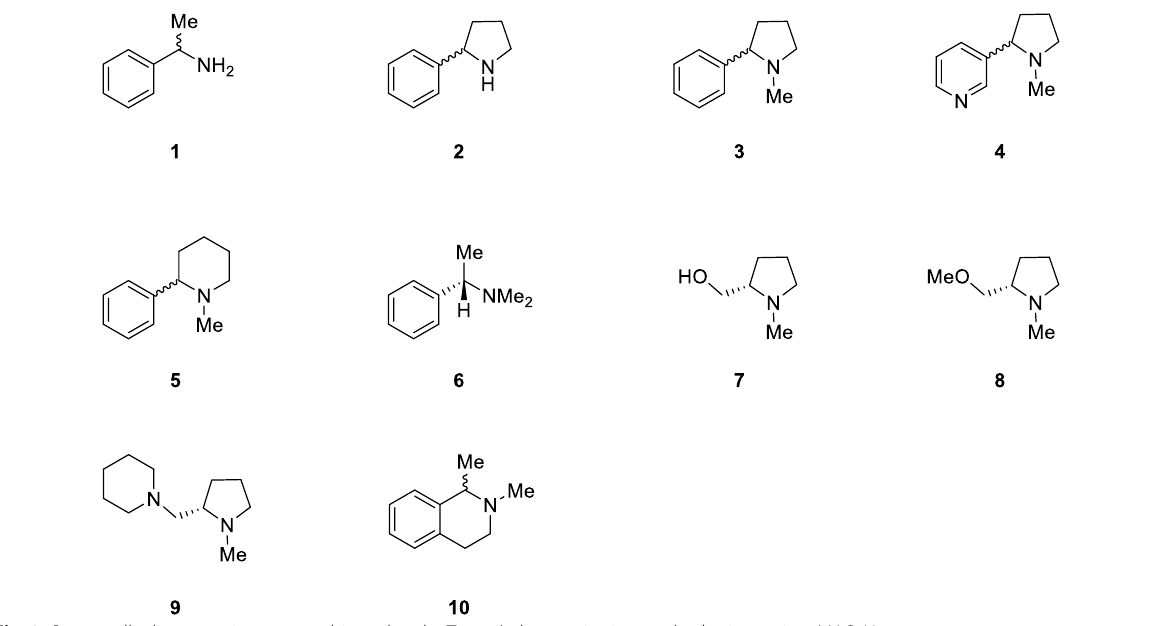
Fig. 2 Structurally diverse amines were subjected to the Turner’s deracemization method using variant